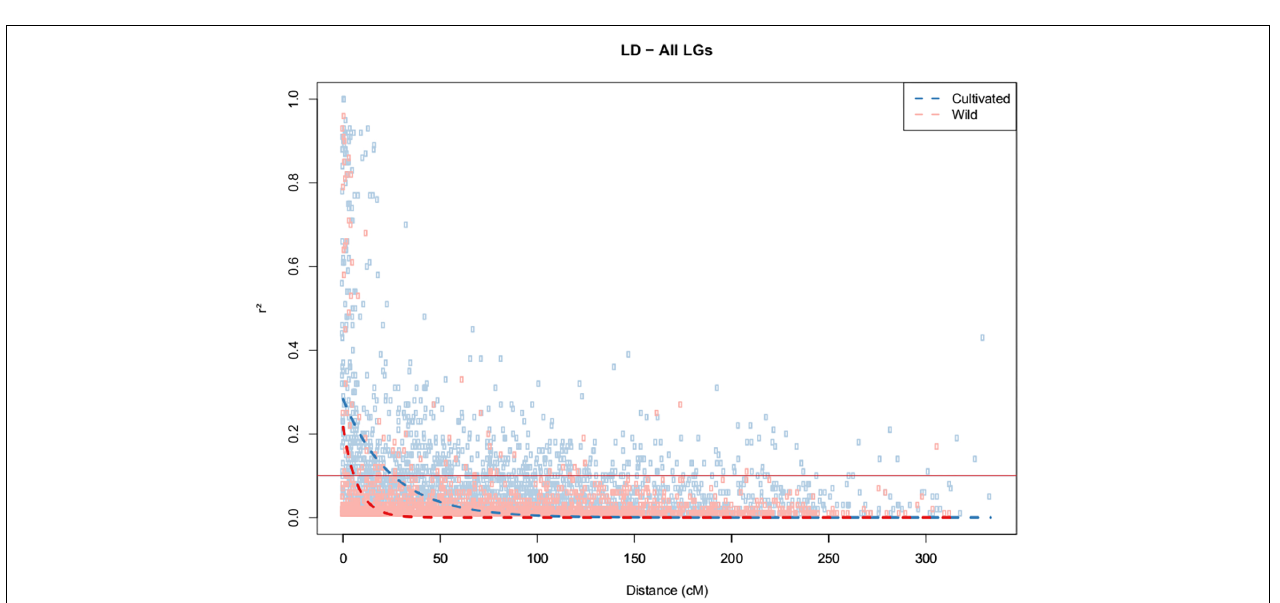
FIGURE 3 | Decay of LD ( r 2 ) as a function of genetic distance (cM) between pairs of loci on all chromosomes. Only r 2 values with P < 0.05 are shown.